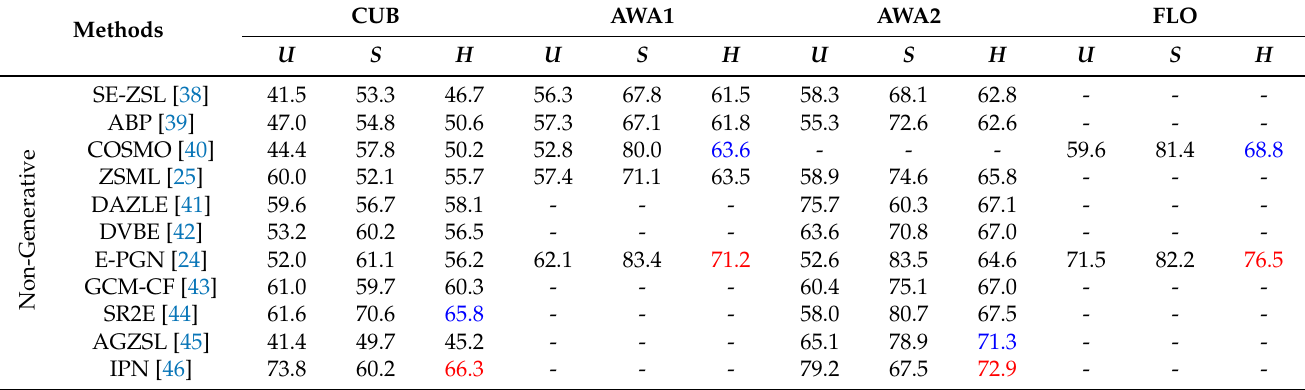
Table 2. Comparative results with other methods. Red font and blue font denote the highest and the second highest results,